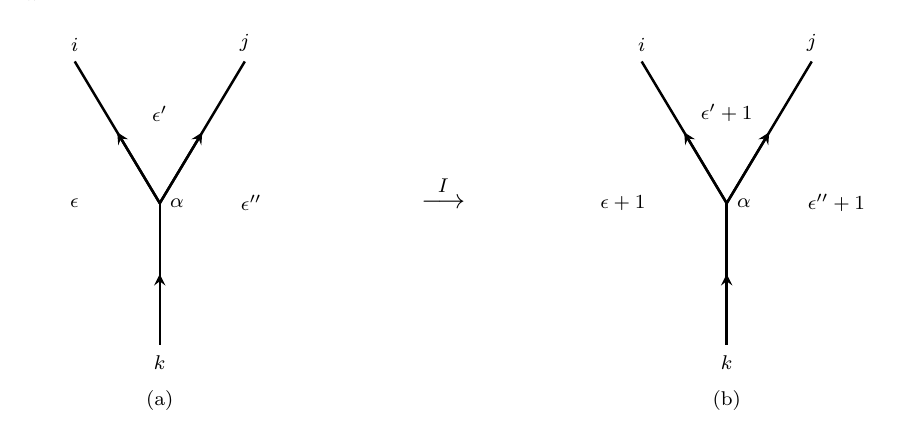
Figure 12 . (a) A line in ~ C (cid:15);(cid:15) 0 . (b) A sample graph in ~ C showing a morphism (cid:11) in the morphism space ( V ij ) (cid:15) . k